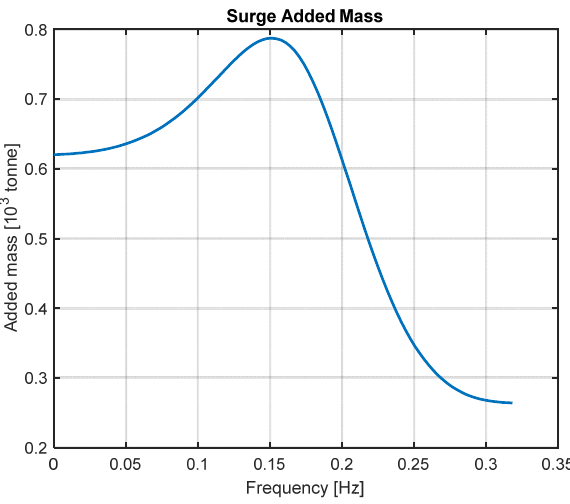
Figure 4. Added mass coefficient.